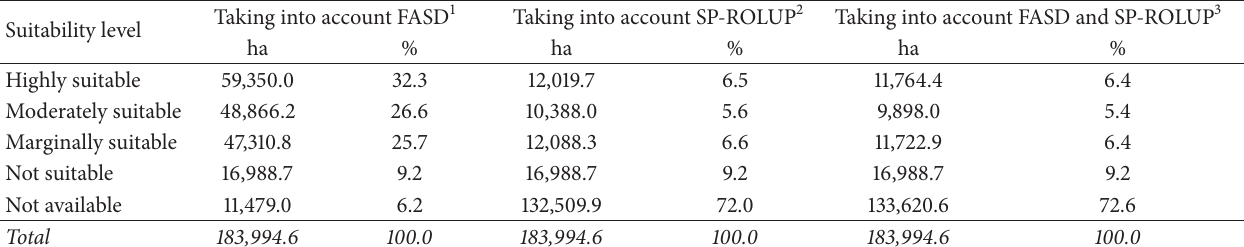
Table 6: Distribution area of suitable land which is available for agriculture in Tuban Regency.